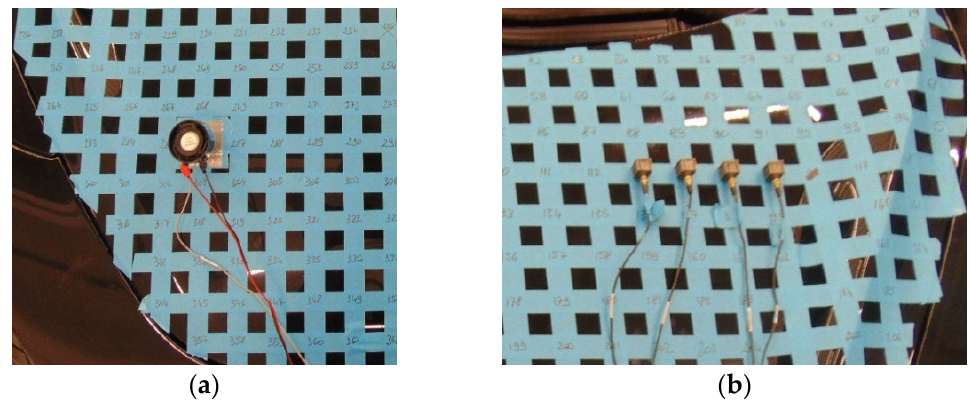
Figure 7. ( a ) Details of the test vehicle bonnet, with a mini-shaker on the bottom-left. ( b ) Details of the test vehicle bonnet with four accelerometers on the top-right.